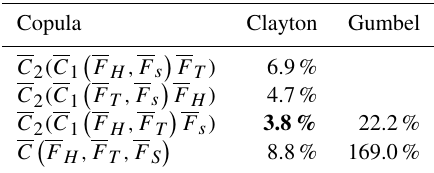
Table 7. Error rate of the different trivariate copulas for the port of Le Havre.